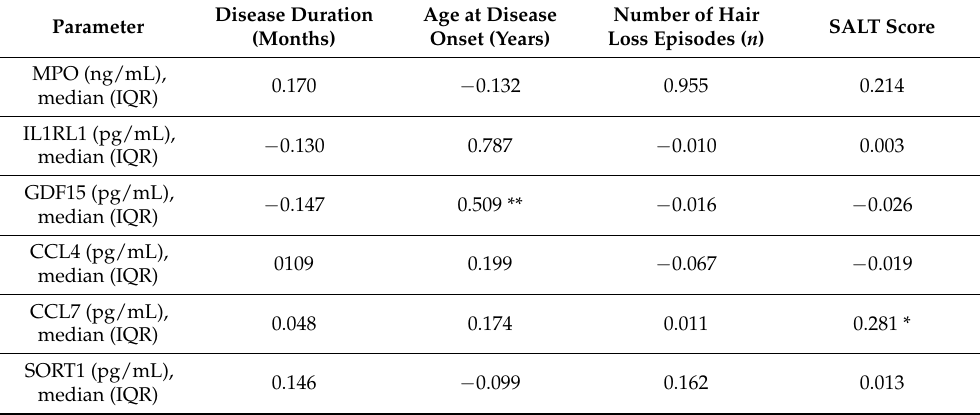
Table 2. Spearman’s correlation coefficients between selected clinical and laboratory parameters